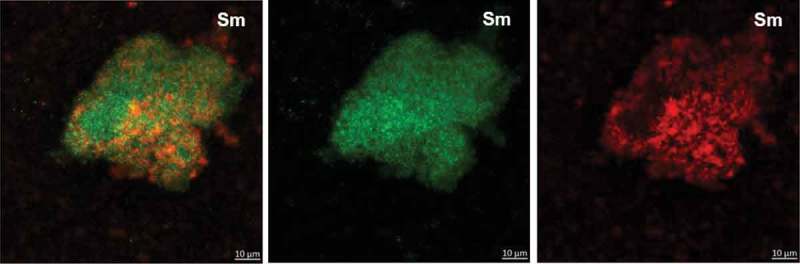
Representative confocal microscopy images of 19 h-old S. mutans single-species biofilm. The green color represents the S. mutans cells (GFP), while the red color represents exopolysaccharides in the extracellular matrix labeled with Alexa Fluor 647. In the first column overlay is observed, while the second and third illustrate each component individually.